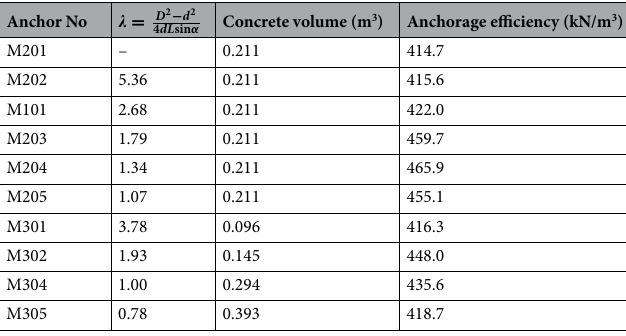
Table 9. Anchorage efficiency anchors.